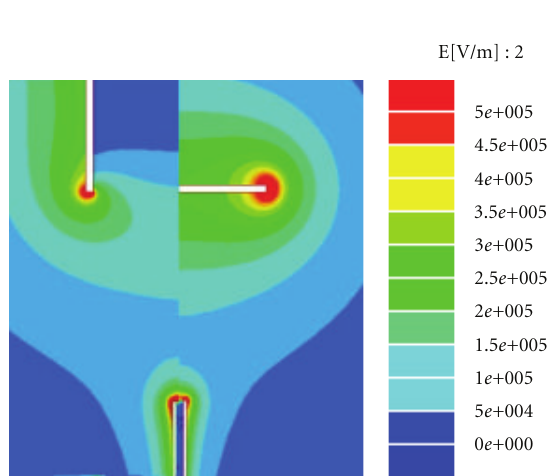
Figure 10: Comparison of tube and plate.